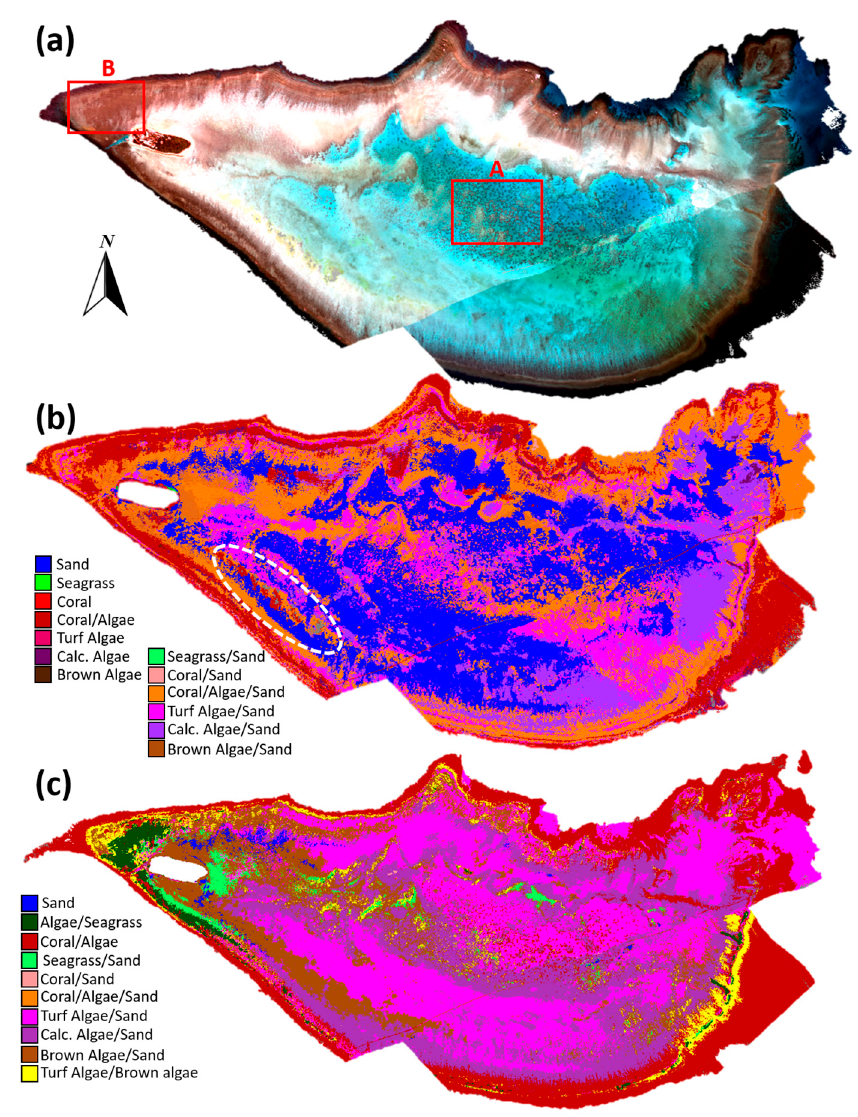
Figure 5. Comparison between ( a ) the pseudo RGB of Heron Reef ( b ) the HOPE-LUT classification map, and ( c ) the BRUCE classification map. Here, pixels with retrieved depths greater than 12 m were not shown. Regions A and B in ( a ) highlights the inner lagoon and reef flat respectively. The highlighted region in ( b ) are bright green patches that are likely to be benthic microalgae.